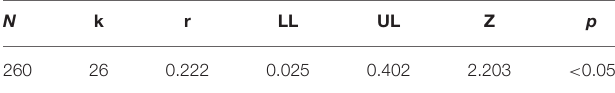
TABLE 5 | Random effects model analysis